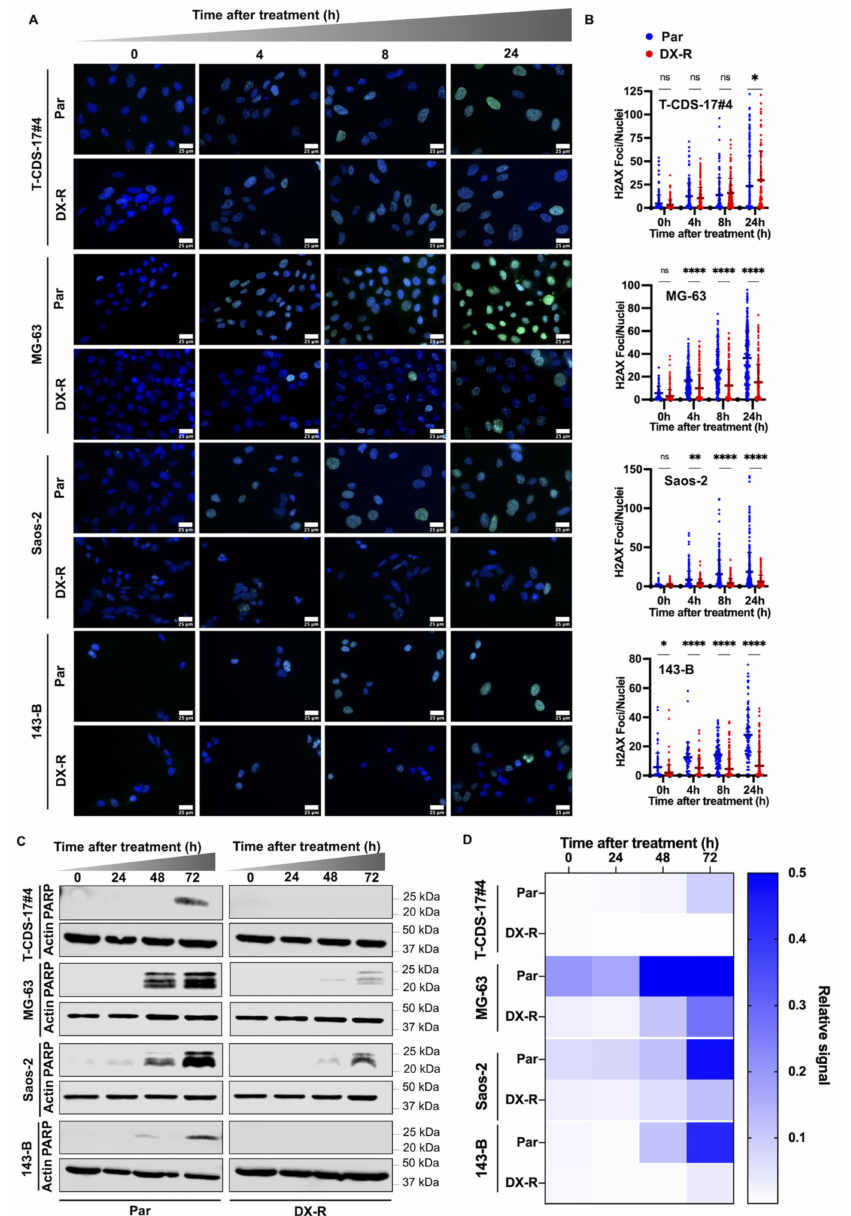
Figure 3. Induction of DNA damage and apoptosis in DX-R bone sarcoma models. ( A , B ) Analysis of the formation of γ -H2AX foci in parental and DX-R bone sarcoma cell lines after treatment with 1 µ M DOX for 0 h (control), 4 h, 8 h or 24 h. ( A ) Representative images of immunostaining experiments ( γ -H2AX immunodetection: green fluorescence; DAPI staining: blue fluorescence) for each condition. Scale bars = 25 µ m. ( B ) Quantification of the γ -H2AX foci. Means (horizontal bars) and SD of the number of foci of at least 100 cells for each condition are shown. Asterisks indicate statistically significant differences between groups in one-way ANOVA test (ns: p > 0.05; *: p < 0.05; **: p < 0.01; ****: p < 0.0001). ( C ) Western blotting analyses of cleaved PARP1 (PARP) levels in parental and DX-R bone sarcoma cell lines treated with their respective IC 50 concentrations of DOX (90 nM for T-CDS-17#4, 61 nM for MG-63, 37 nM for Saos-2 and 50 nM for 143-B) for the indicated times. β -Actin levels were used as loading controls. ( D ) Quantification of the Western blotting analyses. Protein levels were normalized to β